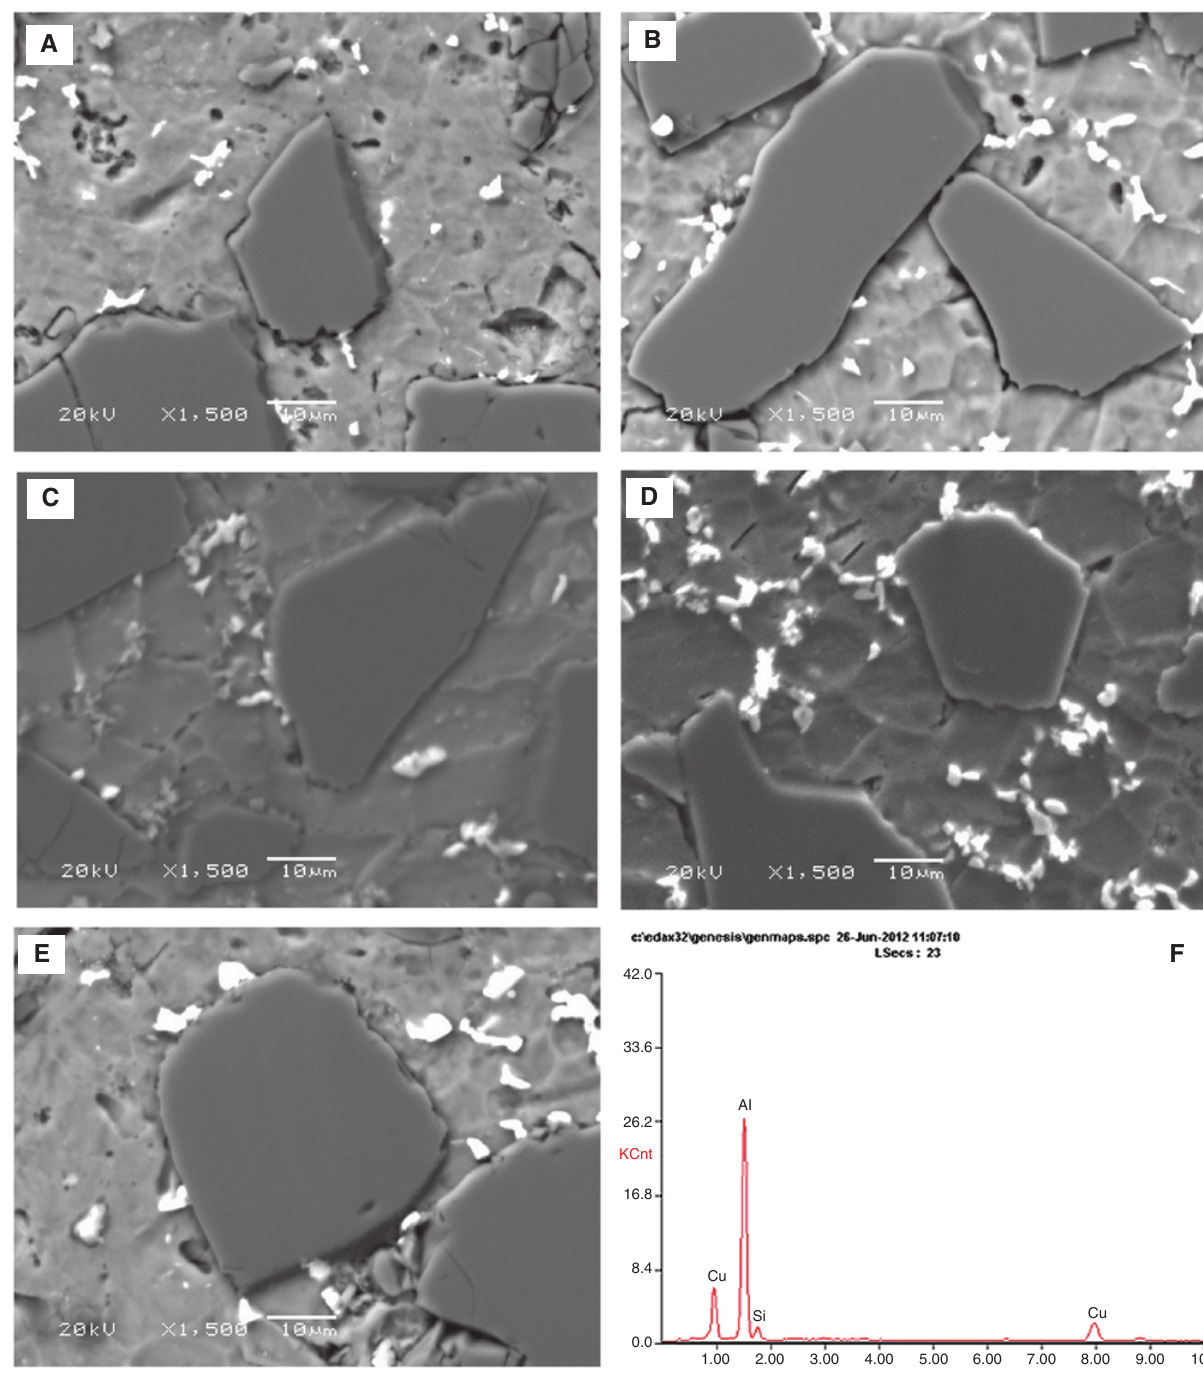
Figure 4 Secondary electron SEM micrographs of 30%SiCp/2024Al composites made at hot pressing temperatures of (A) 520 ° C, (B) 540 ° C, (C) 560 ° C, (D) 580 ° C, (E) 600 ° C and (F) EDS of white particles from (E)